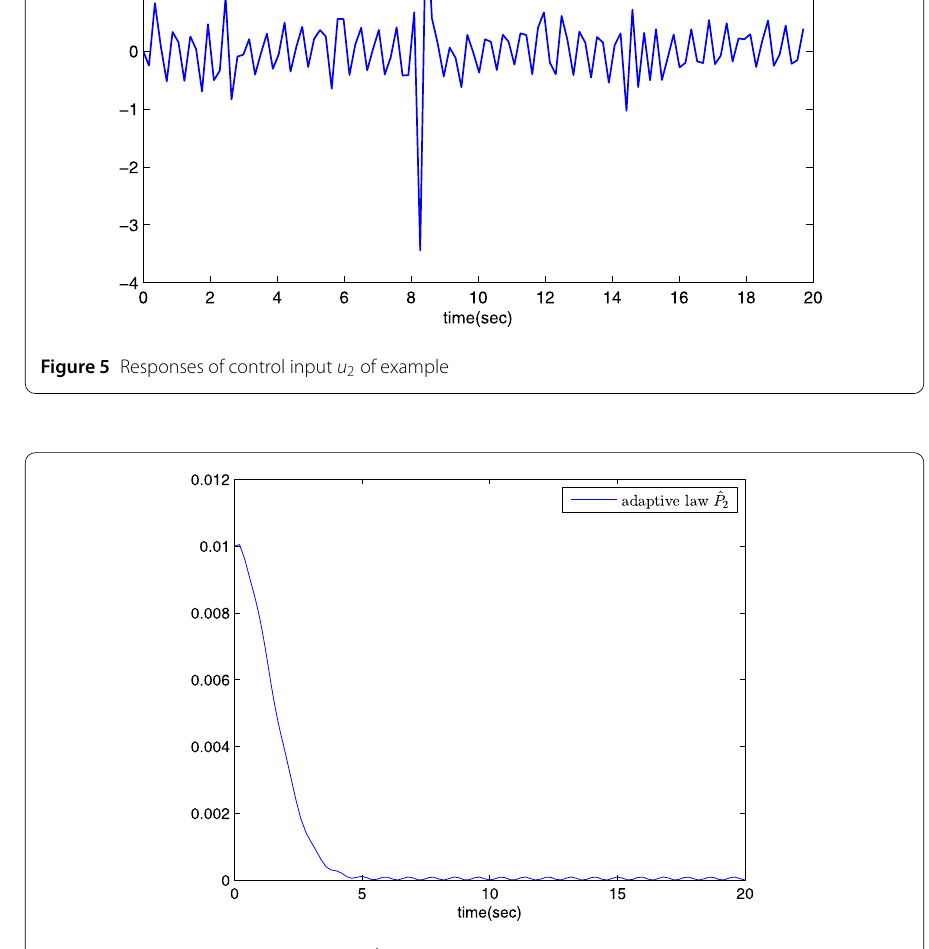
Figure 6 Responses of the adaptive laws ˆ P 2 of Example